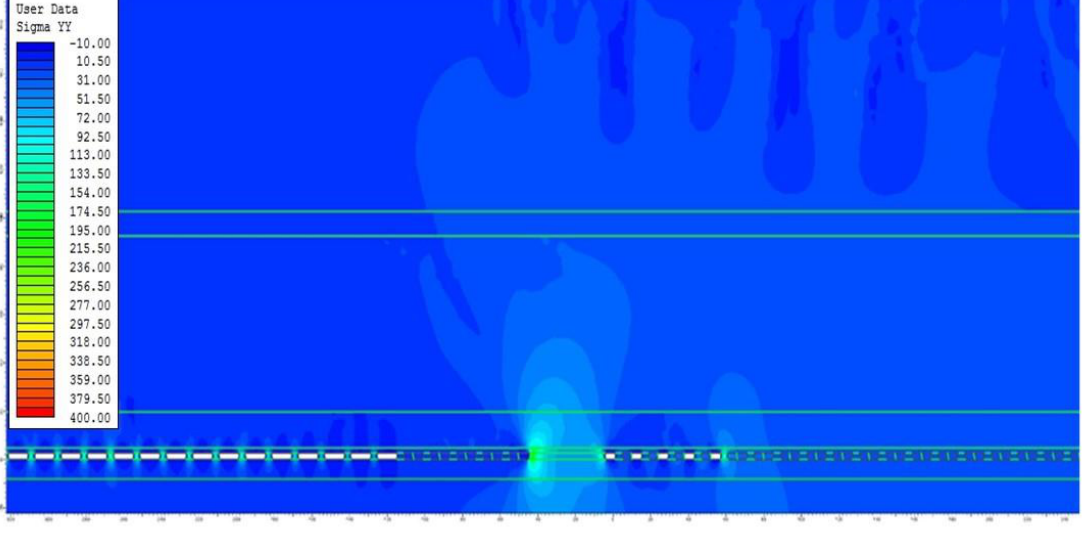
Figure 12. Distribution of vertical stresses σ y for the front distance approximately 60 m from the remnant edge—36th calculation step.